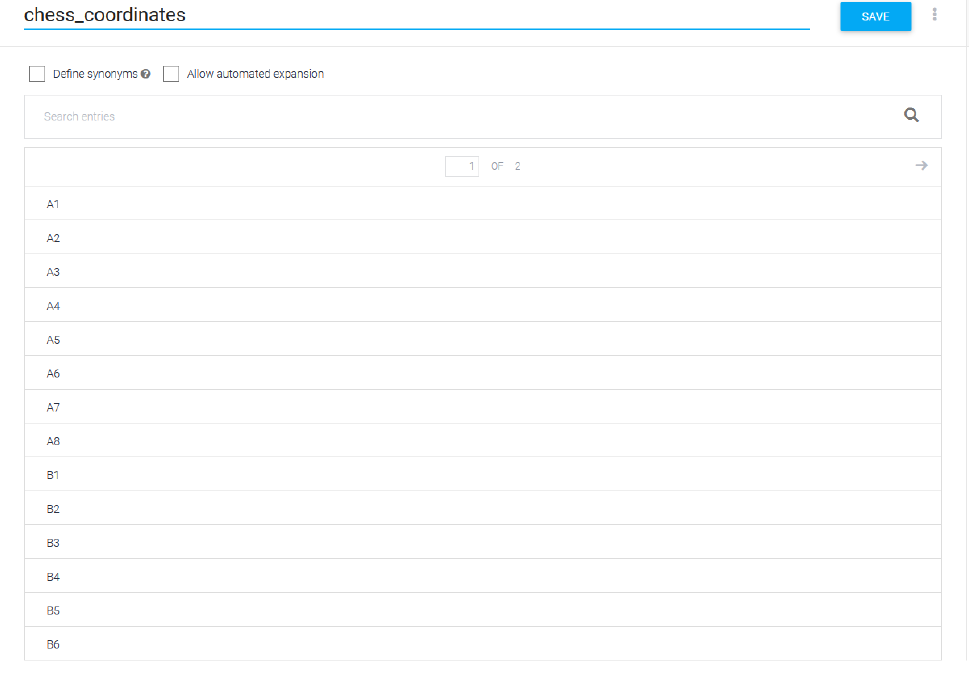
Figure 3. A screenshot of DialogFlow after the definition of the entities of the chess game. The entities are represented by coordinates that the user says to specify a move from a start position to an end